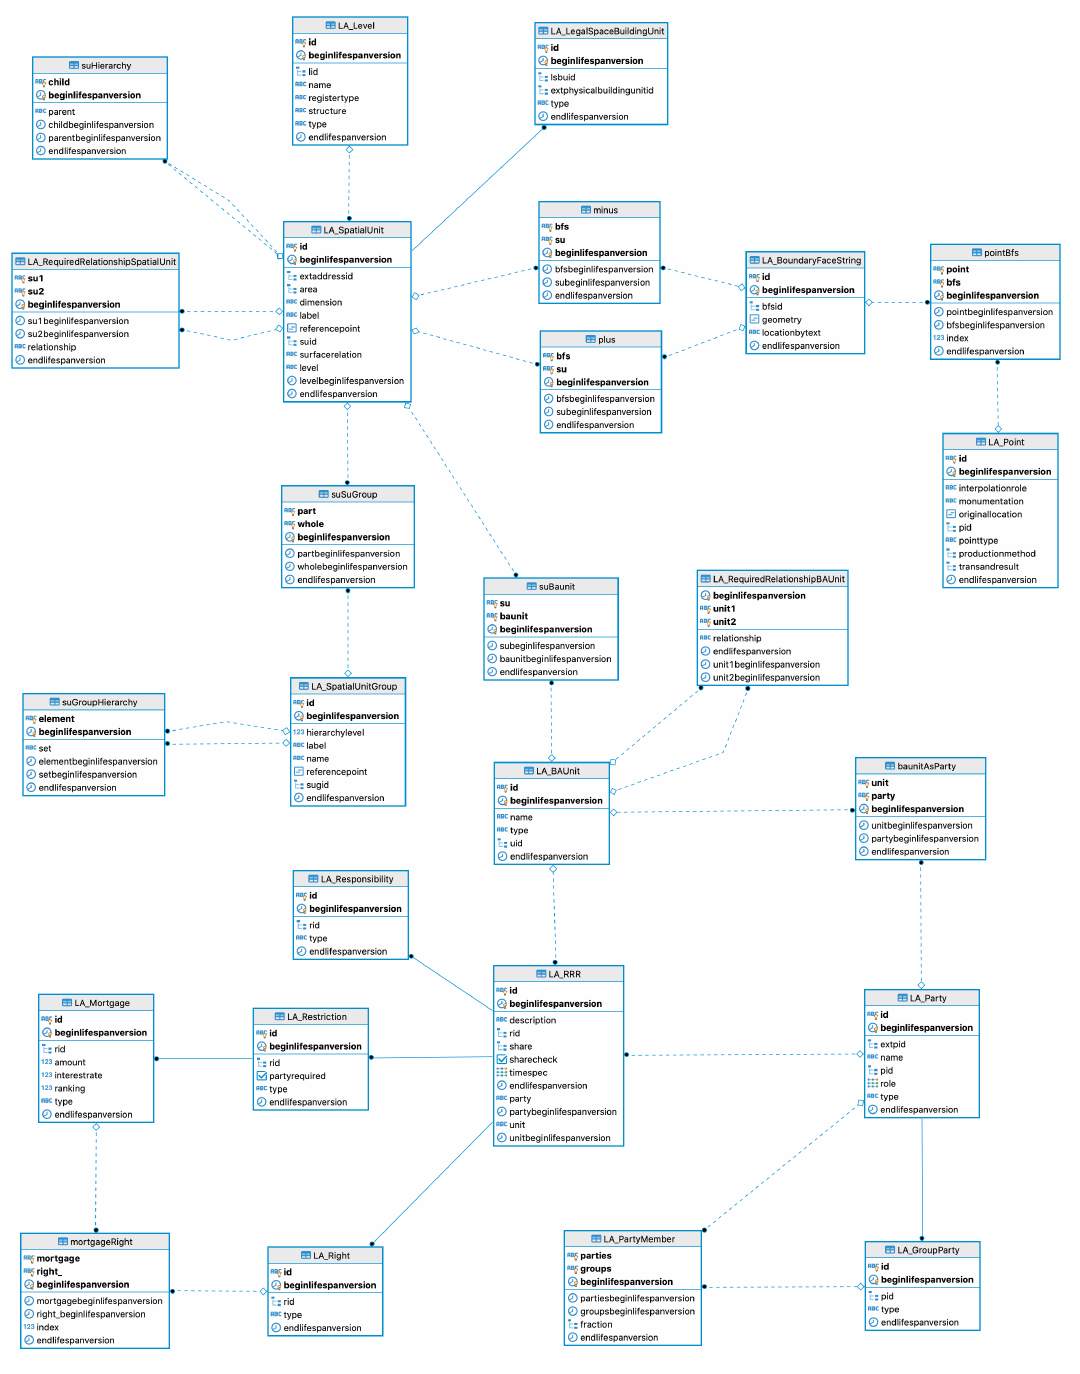
Figure 1. Entity-relationship (ER) model of